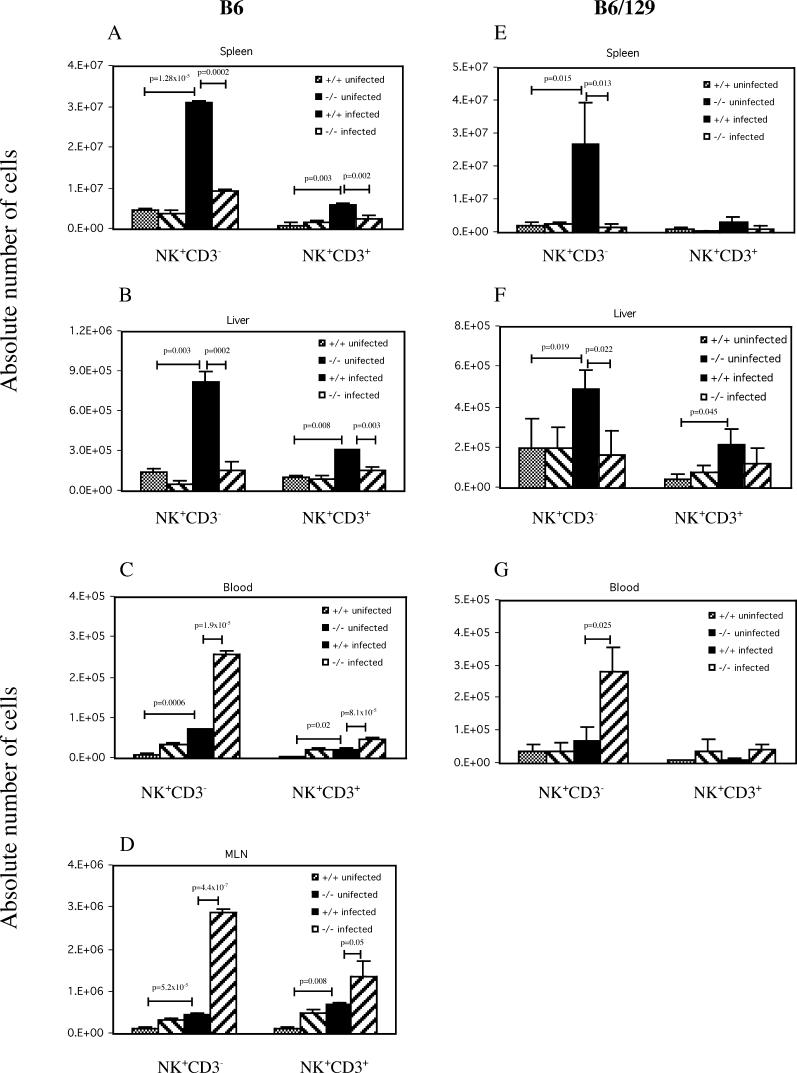
NK and NK T Cell Numbers in T. gondii-Infected CCR5−/− and CCR5+/+ Mice in the C57BL/6 and C57BL/6x129 BackgroundsCCR5+/+ and CCR5−/− mice in C57BL/6 and C57BL/6 × 129 backgrounds (three mice per group) were infected with 15 T. gondii cysts. At day 7 PI, lymphocytes from spleen (A and E), liver (B and F), blood (C and G), and mesenteric lymph nodes (D) were isolated and phenotyped for CD3+ and NK1.1+ by FACS analysis. NK1.1+CD3− and NK1.1+CD3+ cell numbers are graphed. The experiment was performed twice with similar results.